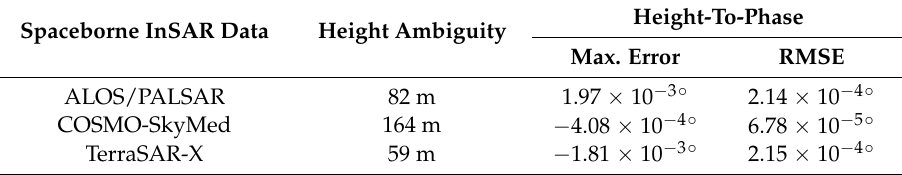
Table 1. Height-to-phase conversion errors of rational function model.